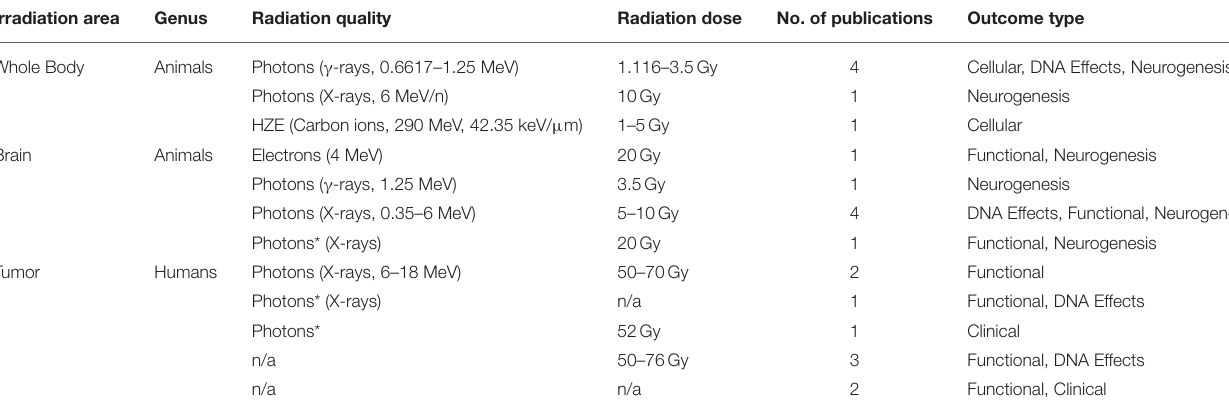
TABLE 1 | Irradiation conditions and outcome types in studied articles.